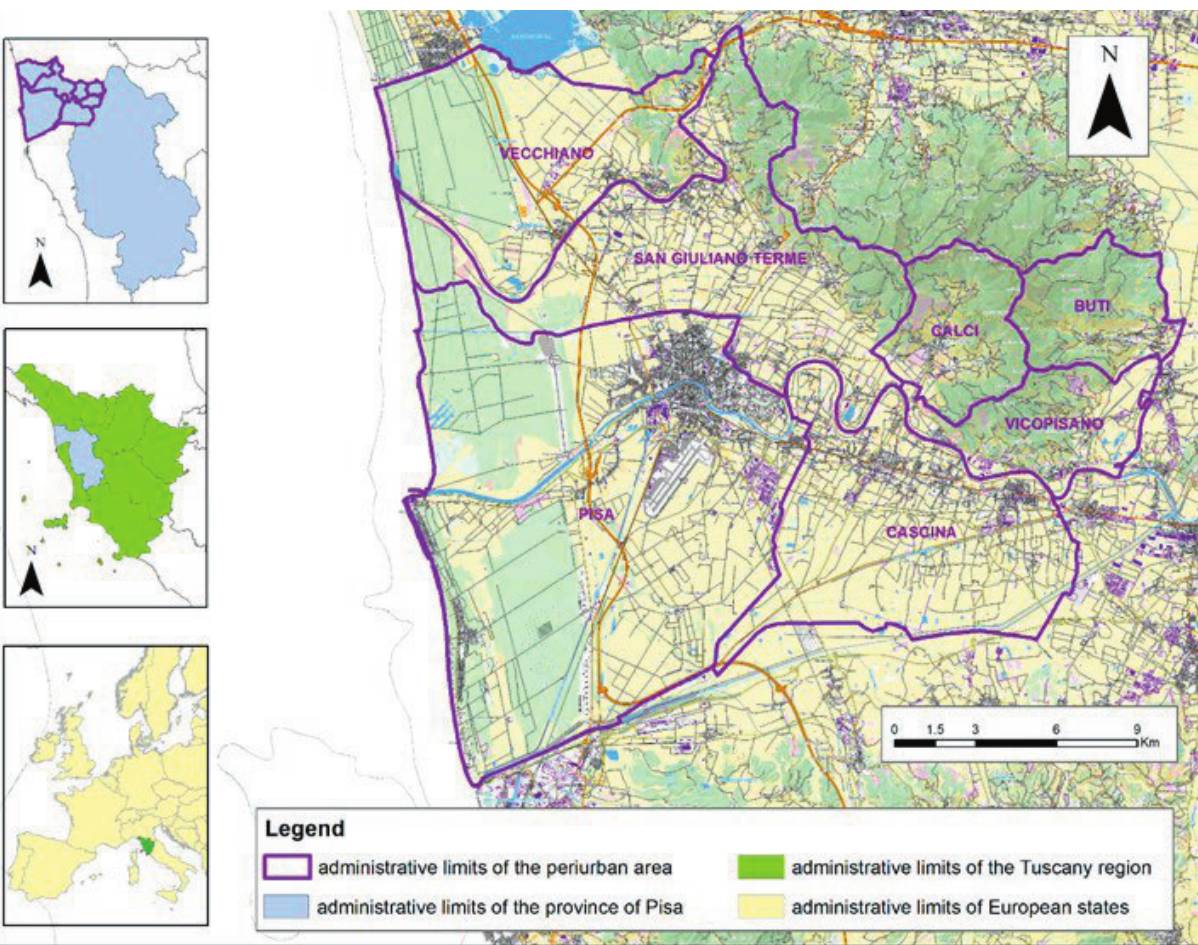
Figure 1. Case study: the periurban area of Pisa (Source: Filippini et al.,